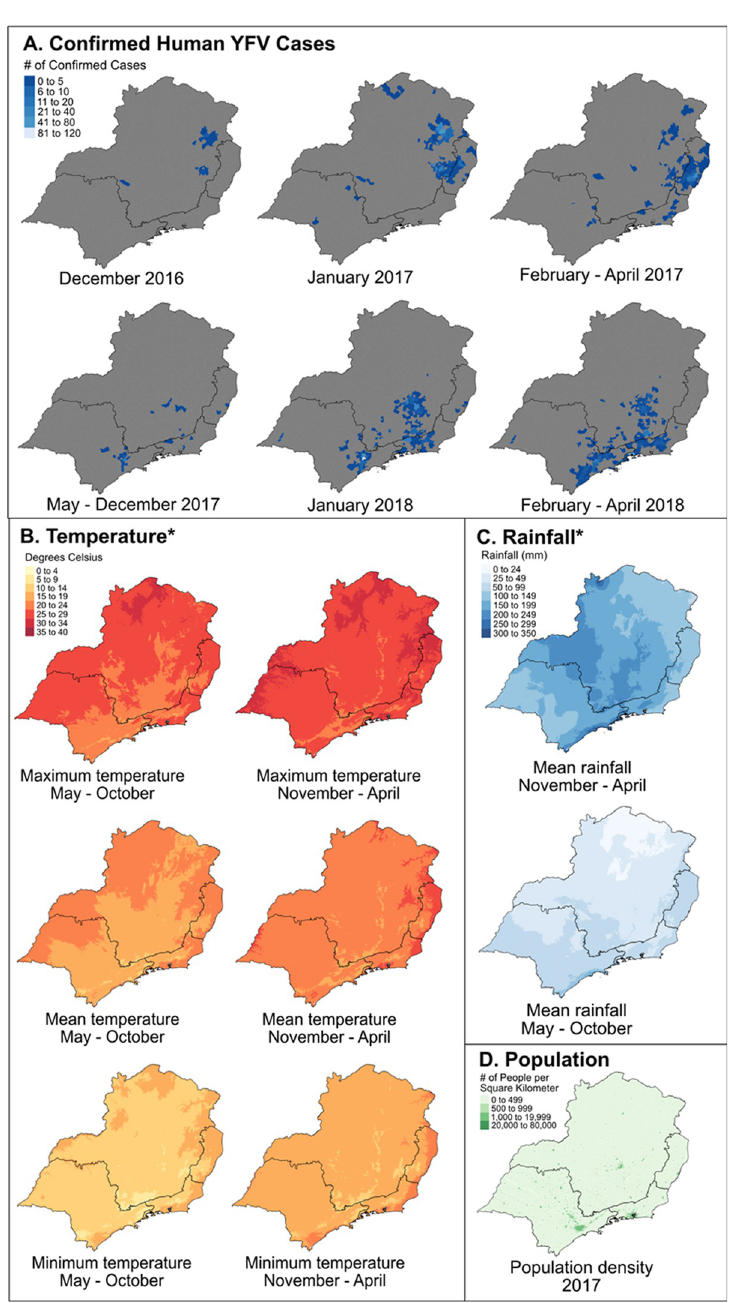
Fig 1. Yellow fever virus outbreak emergence in hot, dry rural areas of southeastern Brazil. Abbreviations: YFV = yellow fever virus; mm = millimeters. A. The YFV outbreak was first identified in the northeastern region of Minas Gerais and subsequently spread east into EspI`rito Santo and then south into S ã o Paulo and Rio de Janeiro. B. The northeastern region of Minas Gerais and EspI`rito Santo experiences the highest temperatures in this region. Maps on the left show the cooler winter months and on the right show the warmer summer months. C. The northern area of Minas Gerais is also the driest part of this region. D. The northeastern region of Minas Gerais is also the most rural and least densely populated part of this region. YFV case data received from SINAN [24]. Municipality boundaries available from the Instituto Brasileiro de Geografia e Estatistica (IBGE). (https://portaldemapas.ibge.gov.br/portal. php#homepage) [26]. � Temperature and rainfall values are derived from the historical average (1970–2000) from WorldClim [20].